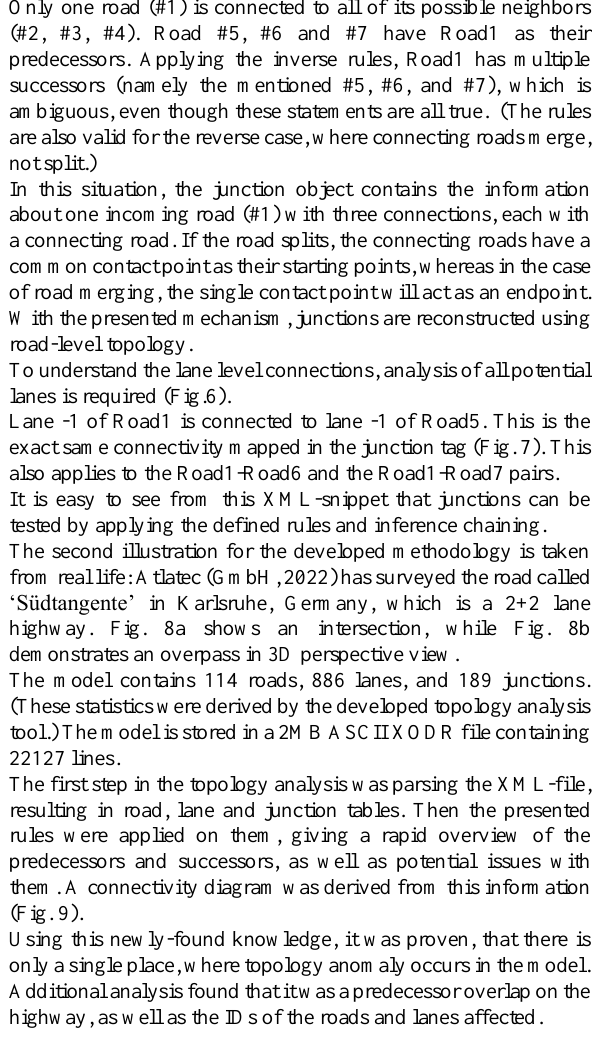
Figure 5. Road reference lines in the simplest example The scenario contains two crossing roads with two lanes